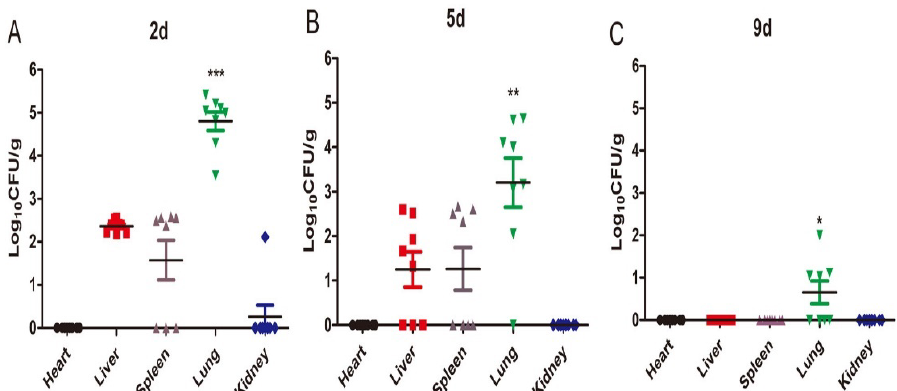
Figure 2. Tissue fungal burden ( A – C ) . Means of fungal burdens in the heart, liver, spleen, lungs, and kidneys of mice (n = 8) on day 2, 5, and 9 after i.v. infection with M. gypseum (4 × 10 6 CFU/mL). The results are presented as mean ± SD and represent three individual experiments (n = 8 mice per group). * p < 0.05; ** p < 0.01; *** p < 0.001.